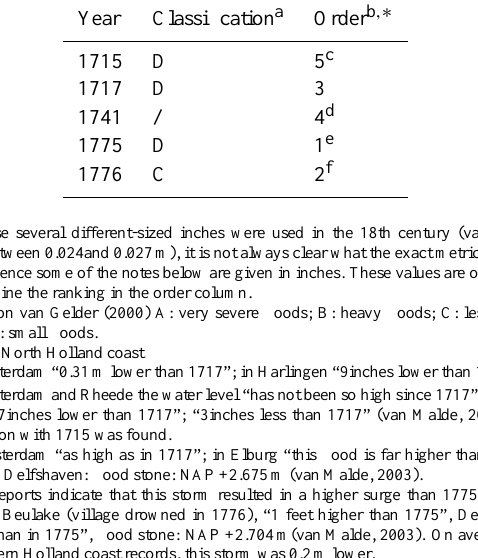
Fig. 1. Map of the locations mentioned in this paper. The Christmas flood of 1717 is analysed at the location of Egmond aan Zee. The 1775 storm is analysed at the Heemskerk